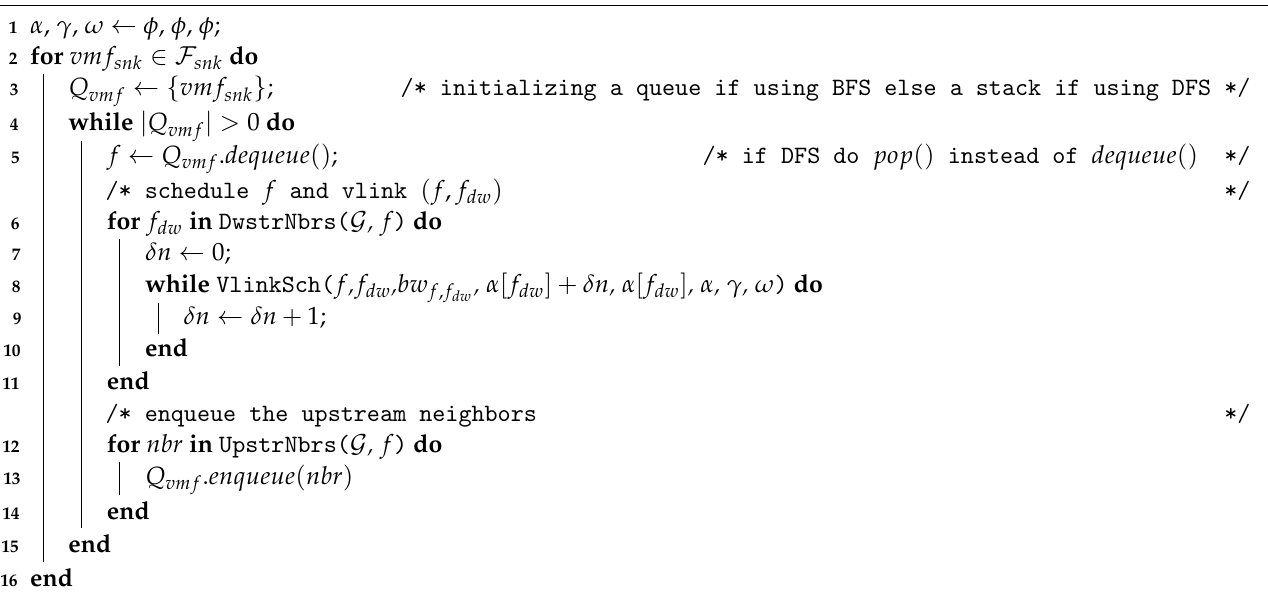
Figure 4. Illustration for the relationship between different VMF timing schedules. Algorithm 1 Simplified pseudocode for the VMF-FG scheduling algorithm; a given VMF-FG G = ( F , L ) is to be scheduled on the MFVi network G I = ( N , E